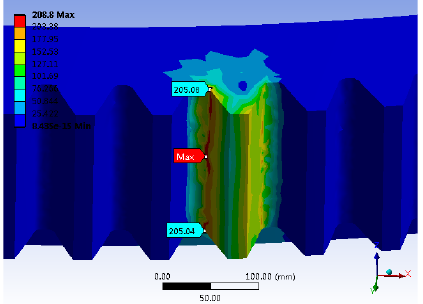
Figure 6. Stress of gear teeth in ideal engagement of large gear ring.